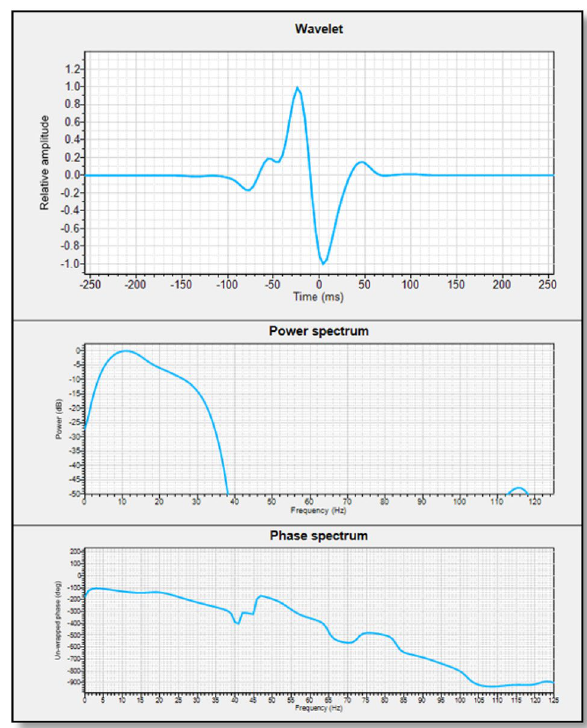
Fig. 8 A zero-phase wavelet used for synthetic